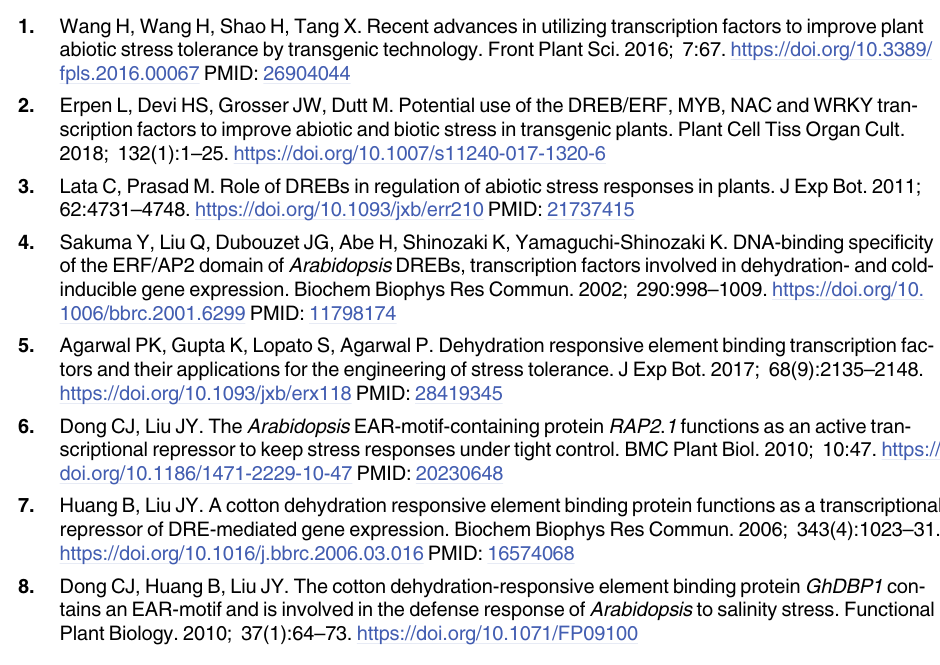
S4 Fig. Evaluation of freezing tolerance of AmDREB3 transgenic Arabidopsis lines at the seedling stage. (TIF) S5 Fig. Evaluation of ABA sensitivity of AmDREB3 transgenic Arabidopsis lines at the seed germination stage. S1 Table. List of primers used in this study. S2 Table. The DREB proteins used in the construction of the phylogenetic tree and their accession numbers. S3 Table. The sequence of AmDREB3 promoter